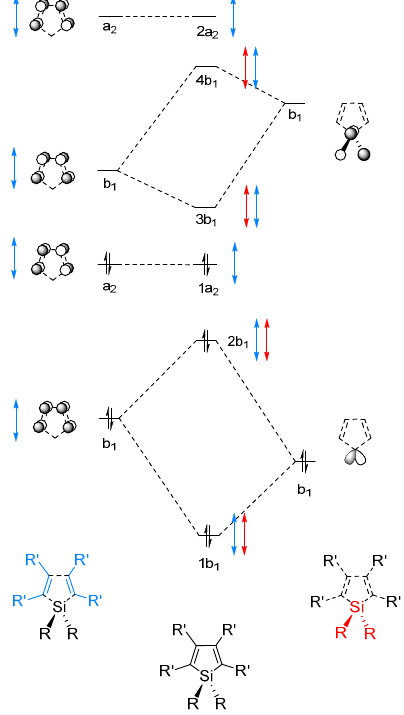
Figure 6. Qualitative molecular orbital (MO) diagram of silole with the lowest few occupied and unoccupied MOs of π -character constructed from suitable fragment orbitals. Red arrows indicate changes in fragment orbital energies in dependence of substituent R and blue arrows indicate changes of substituent R ′ . The orbitals are labeled in accordance with the irreducible representations of the C 2v point group.